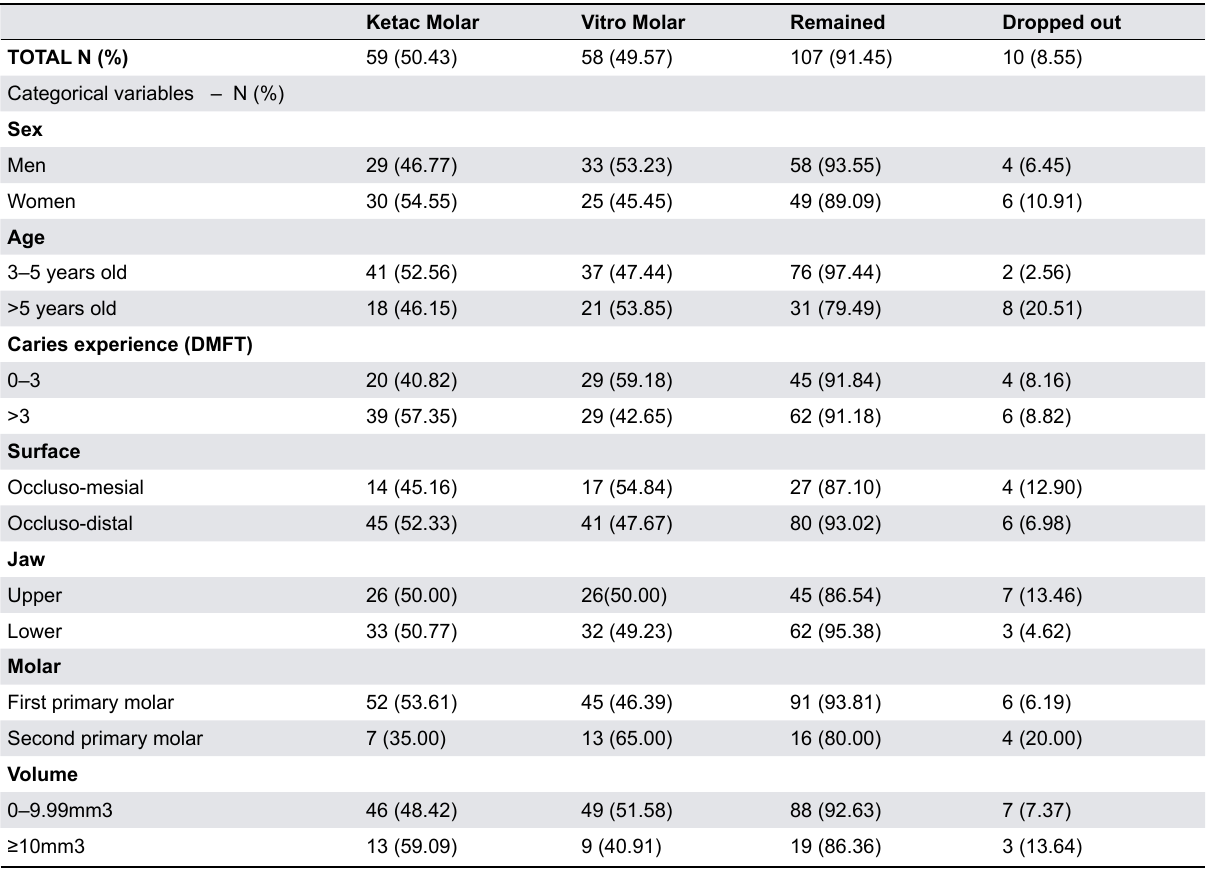
Table 1- Distribution of baseline variables for each group